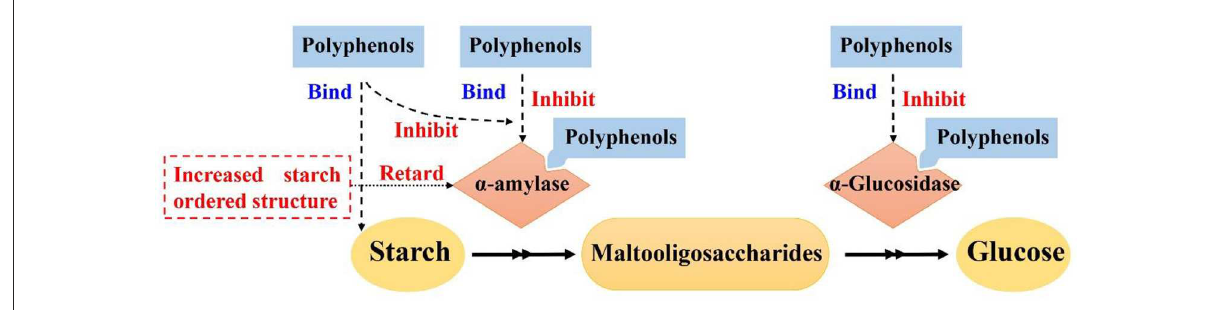
FIGURE2 Mechanism scheme for effects of polyphenols on starch digestion. Figure was adapted from Sun and Miao (16).